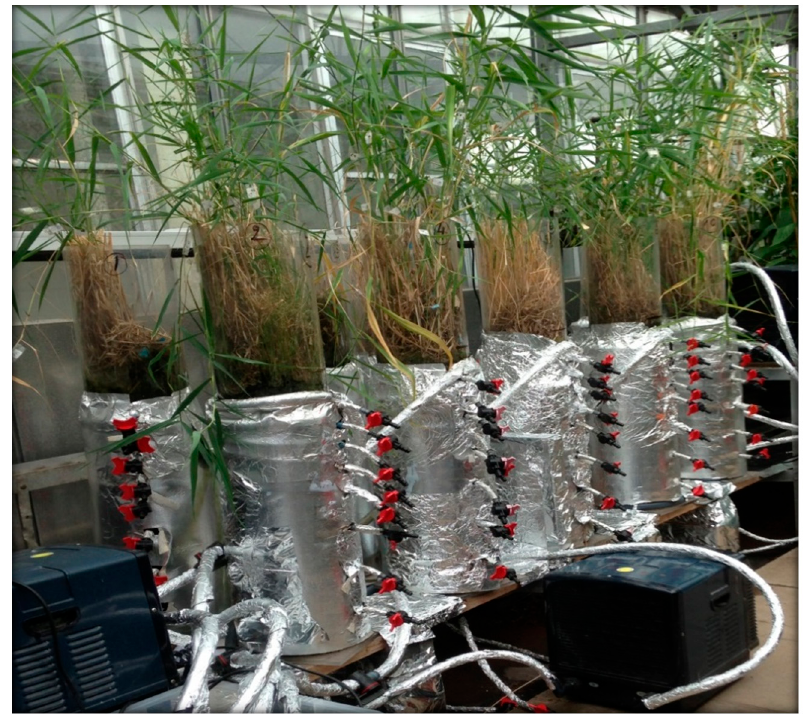
Figure 1 . Experimental set-up of the experimental wetland system. Figure 1. Experimental set-up of the experimental wetland